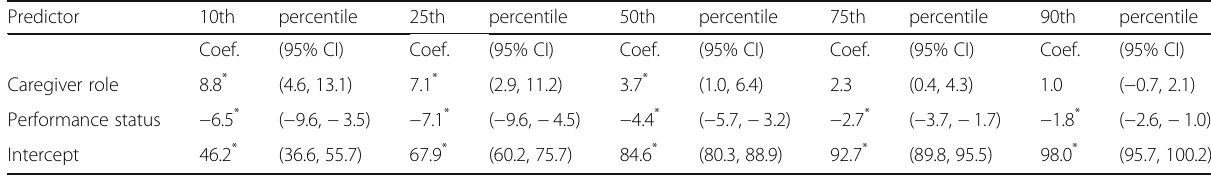
Table 7 Percentiles of QOL Impact on Daily Life score, final model Predictor 10th